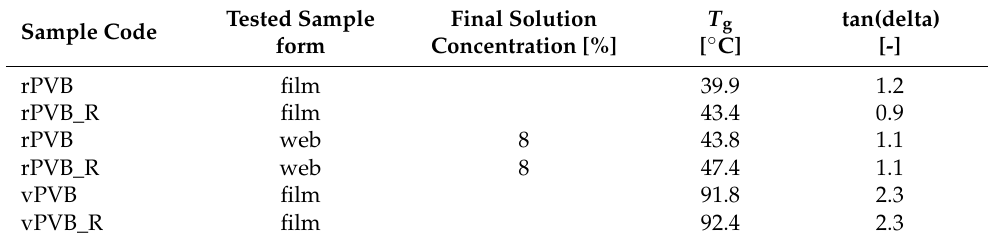
Table 7. Evaluation of T g of rPVB and vPVB films using DMA measurements.